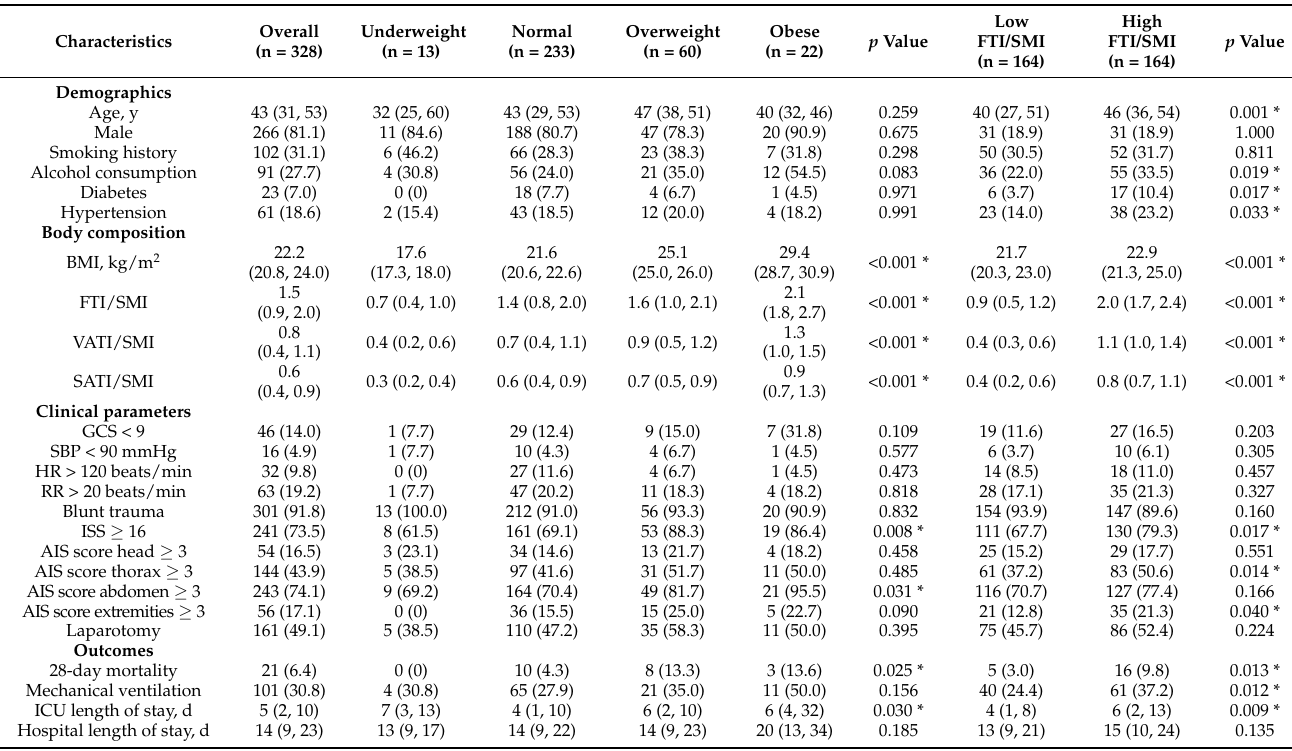
BMI, body mass index; SMI, skeletal muscle index; FTI, fat tissue index; VATI, visceral adipose tissue index; SATI, subcutaneous adipose tissue index; GCS, Glasgow Coma Scale; SBP, systolic blood pressure; HR, heart rate; RR, respiratory rate; ISS, injury severity score; AIS, abbreviated injury scale; ICU, intensive care unit. Data were shown as n (%) for categorical variables, and median (P25, P75) or mean (standard deviation, SD) for continuous variables. * p value < 0.05.